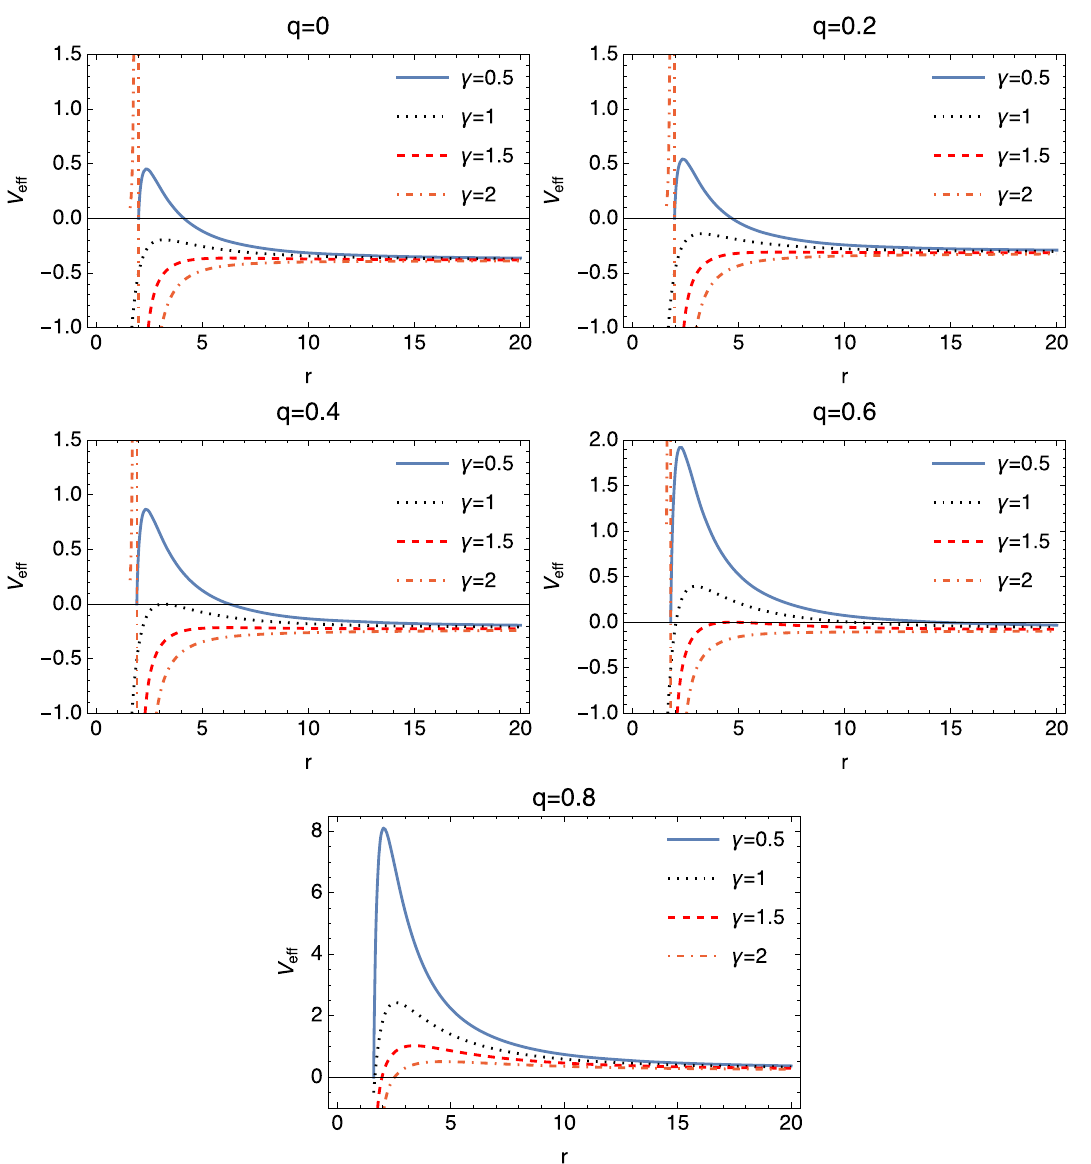
Fig. 3 Radial dependence of the effective potential for a test particle with a charge Q = 1, on the equatorial plane for different values of γ and q . Plots are generated for specific values of m = 1, E = 1 and l =